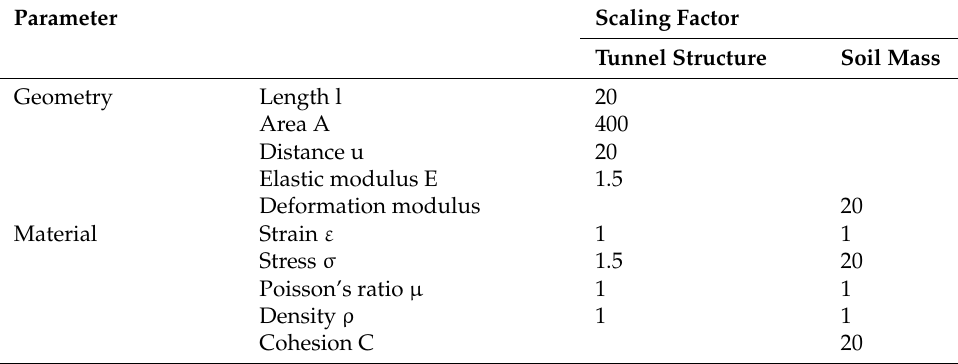
Table 1. Similitude ratio of the model